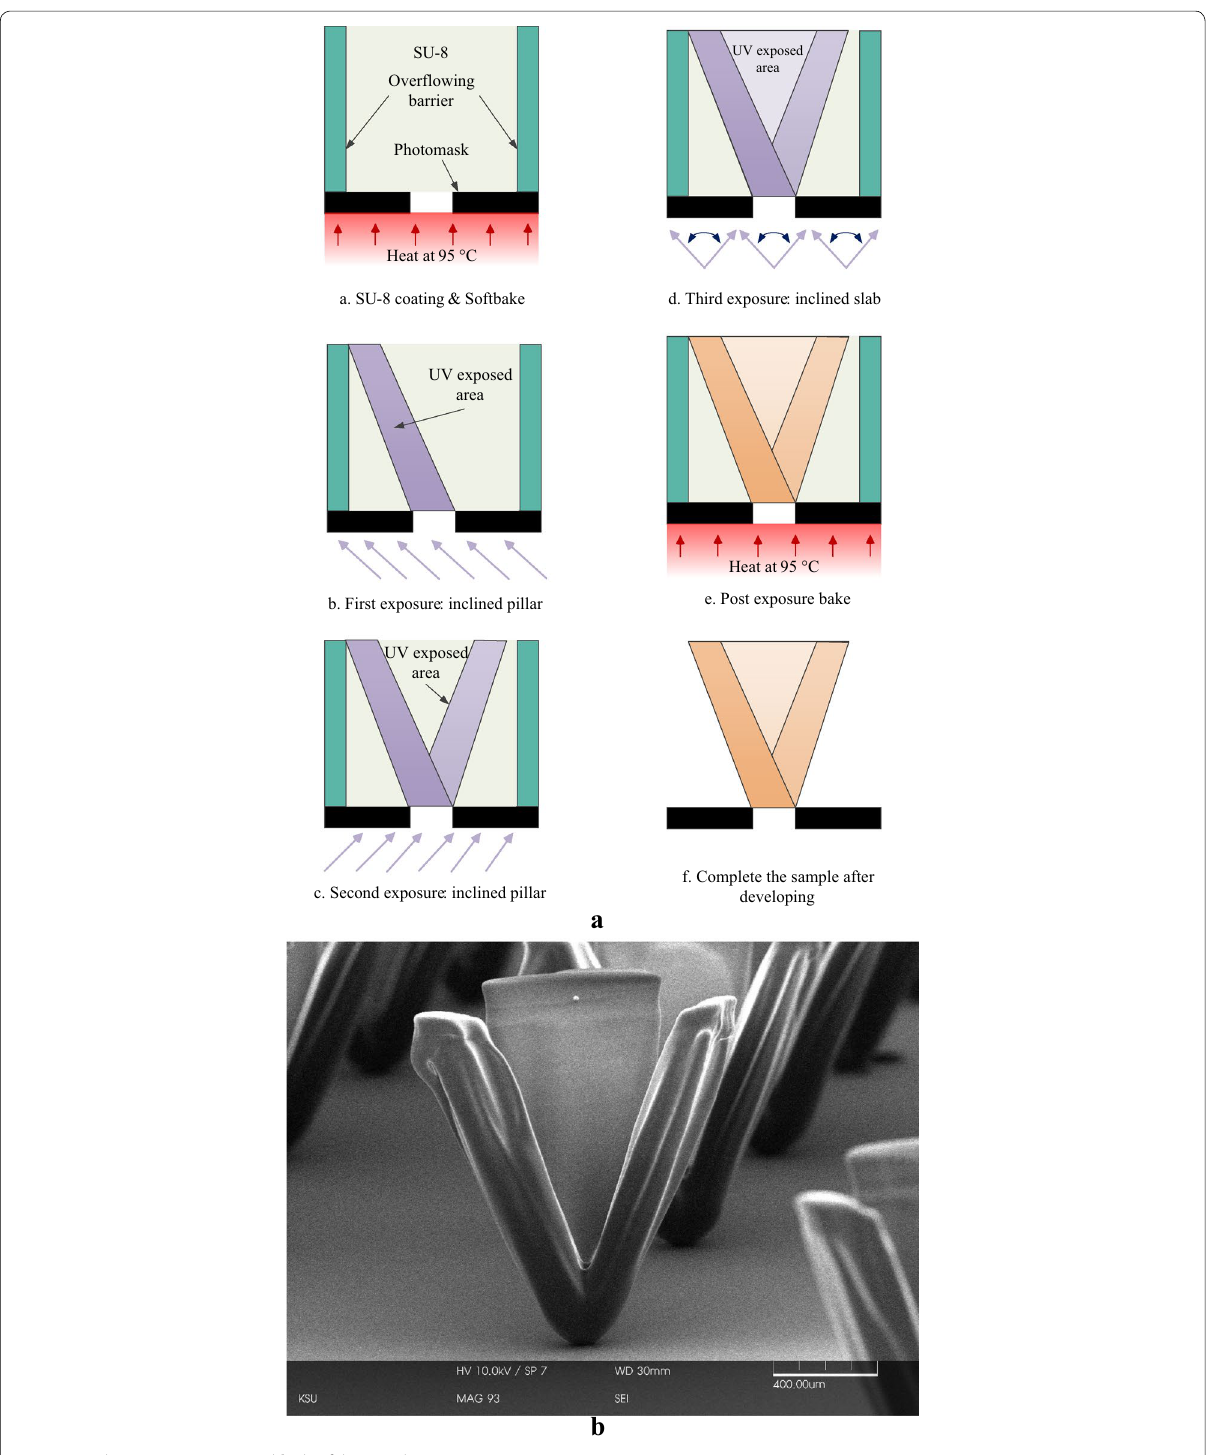
Fig. 5 a Fabrication process and b the fabricated 3D